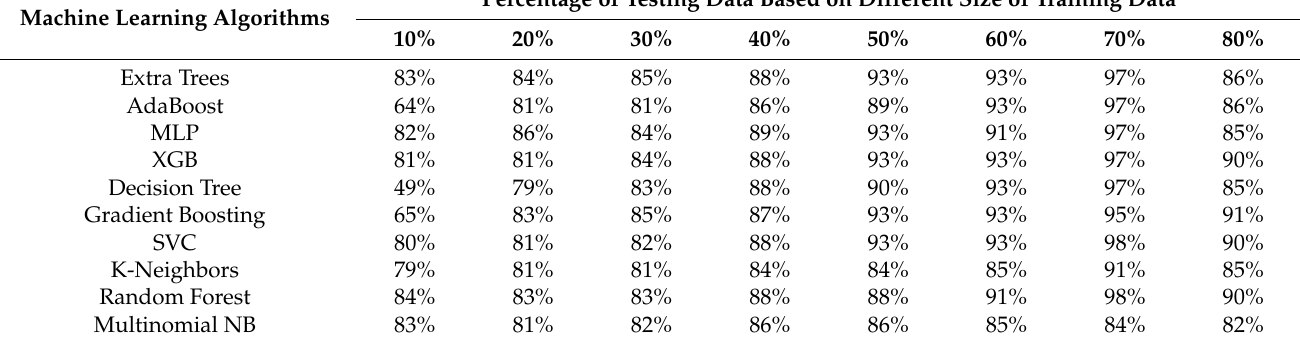
Table 2. Accuracy of testing data based on the percentage of training data. Machine Learning